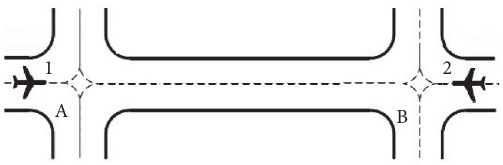
Figure 2: Head-to-head conflict.